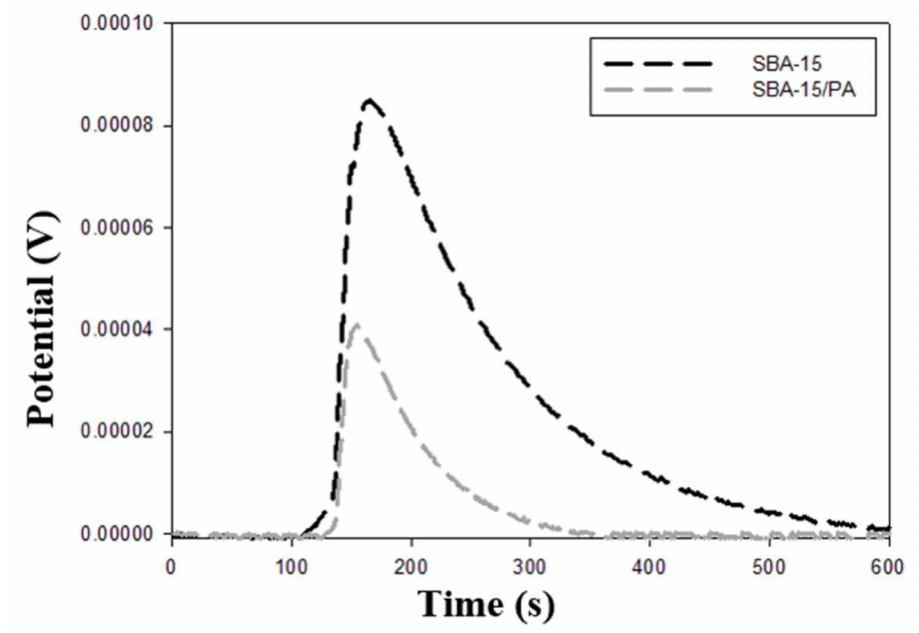
Figure 4. Immersion potentiogram for SBA-15 and its modification in 100 mg L − 1 phenol